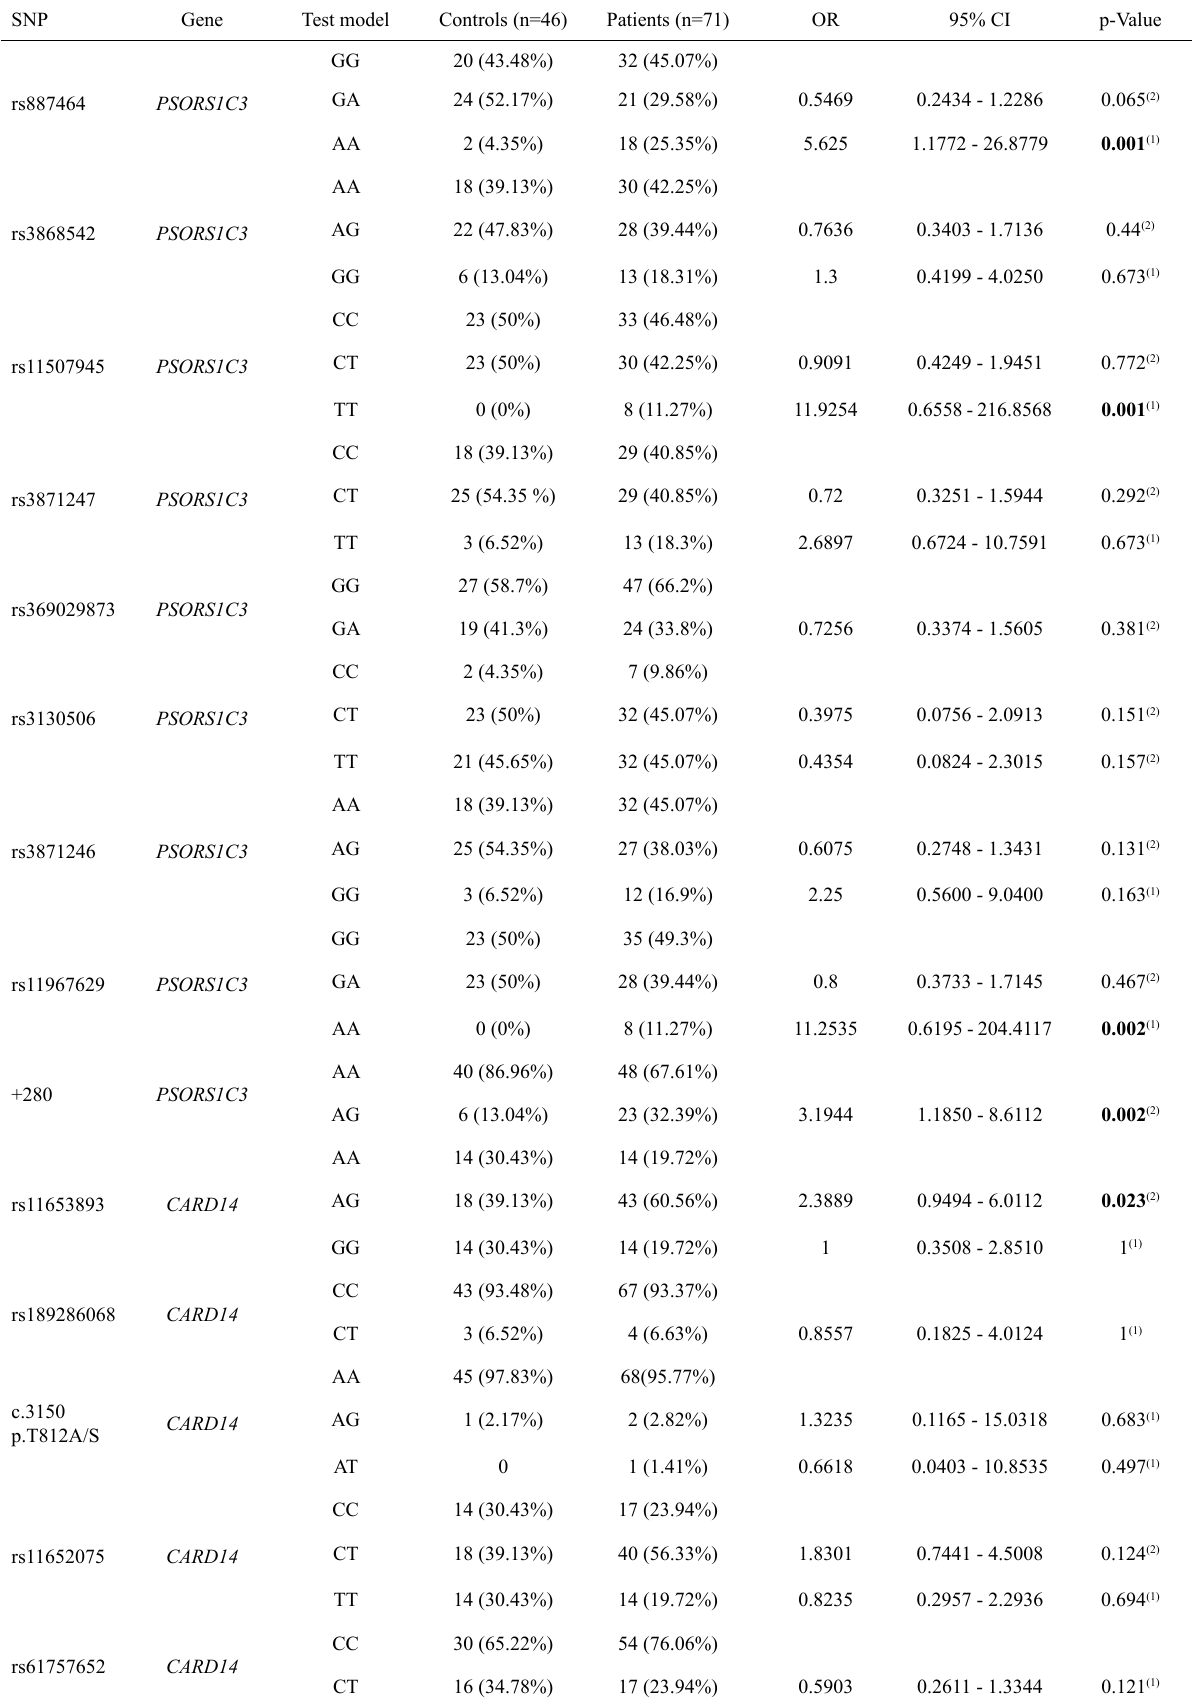
Table 2 – Comparison of genotype frequencies of TLR4, CARD14 and PSORS1C3 variants between psoriatic patients and